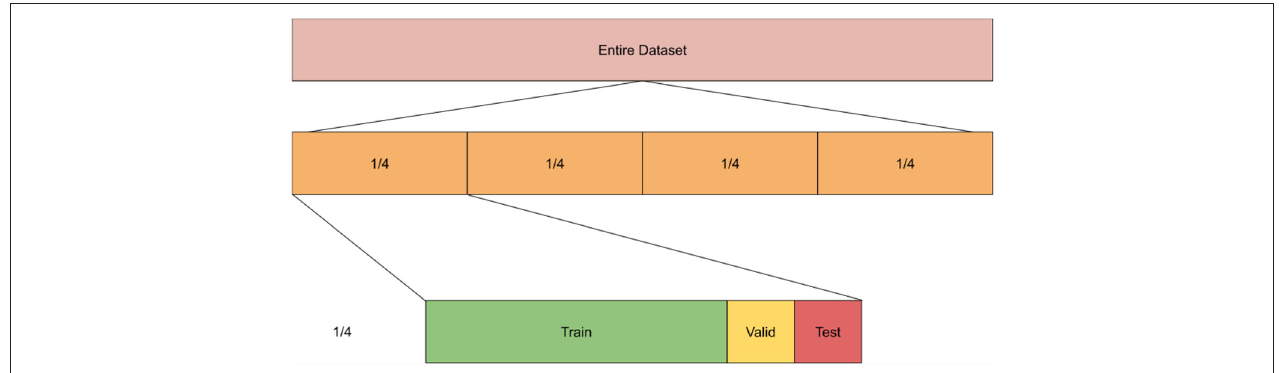
FIGURE 5 | Experiment setup showing 4 splits wherein each split we divide it into training, valid, and testing sets.